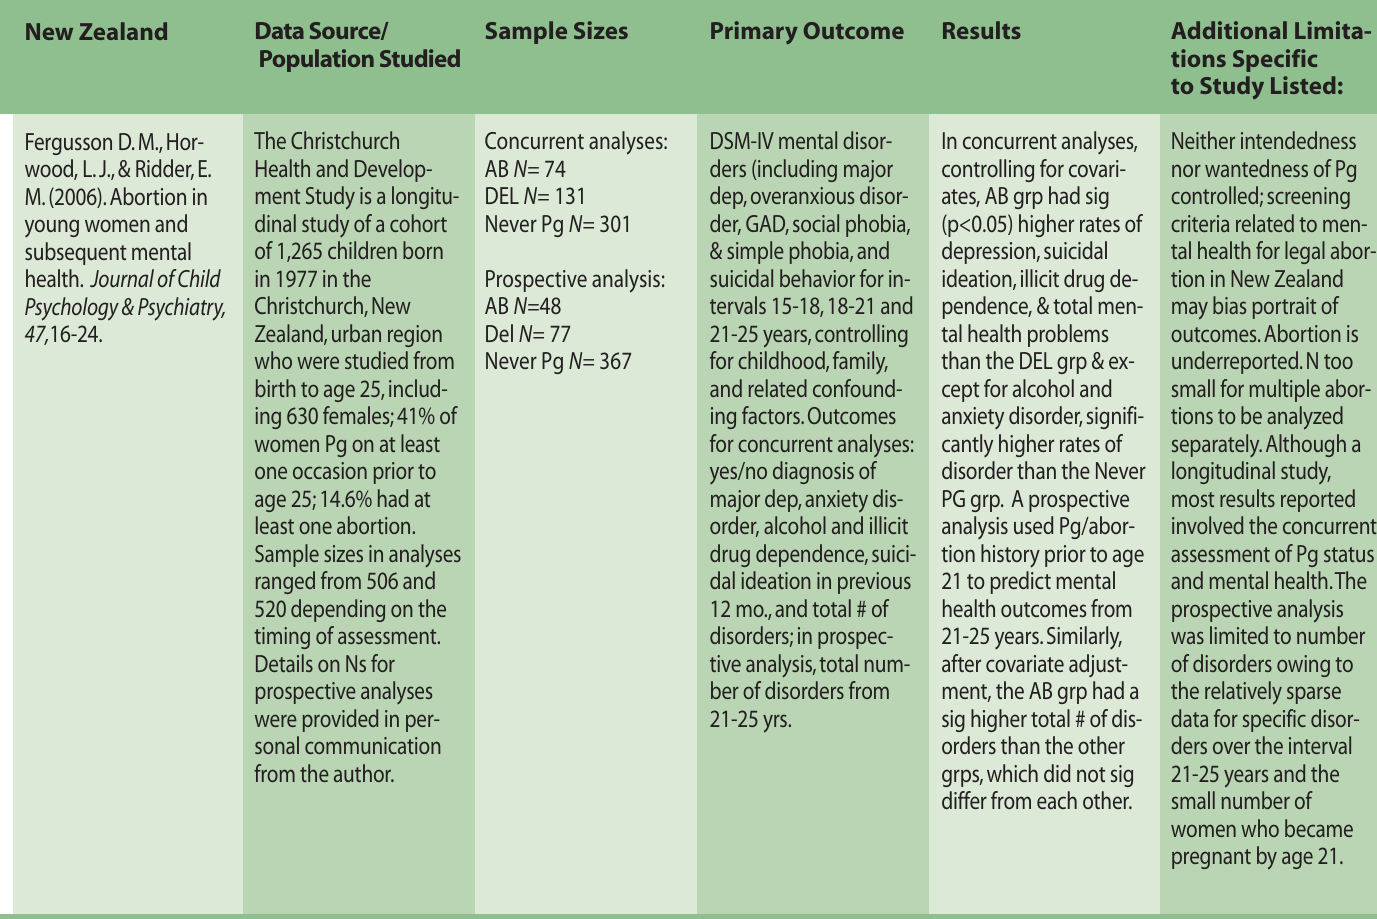
Table 2: Secondary Analyses of Survey Data–Abortion vs.Comparison Groups INTERNATIONAL STUDIES–NEW ZEALAND Christchurch Health and Development